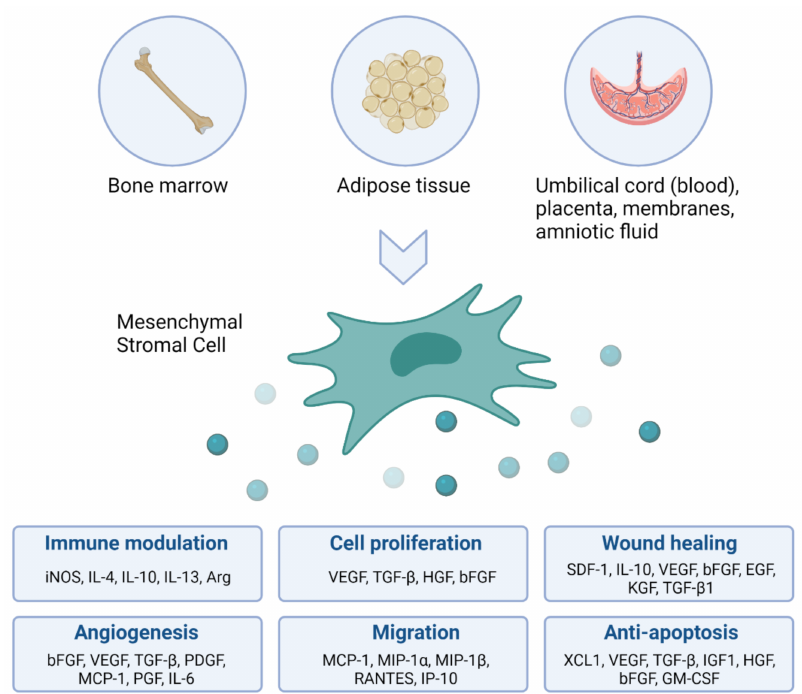
Figure 1. The therapeutic function of mesenchymal stromal cells (MSCs). MSCs can be isolated from a variety of tissue sources. Cultured MSCs have been used for several therapeutic purposes, both in experimental research and clinical applications. MSCs have the ability to modify their pleiotropic effects based on the in vivo environment they encounter. The secretome of MSCs is known to be involved in immune modulation, cell proliferation, wound healing, angiogenesis, migration and anti-apoptosis. Figure created with Biorender.com, accessed on 28 March